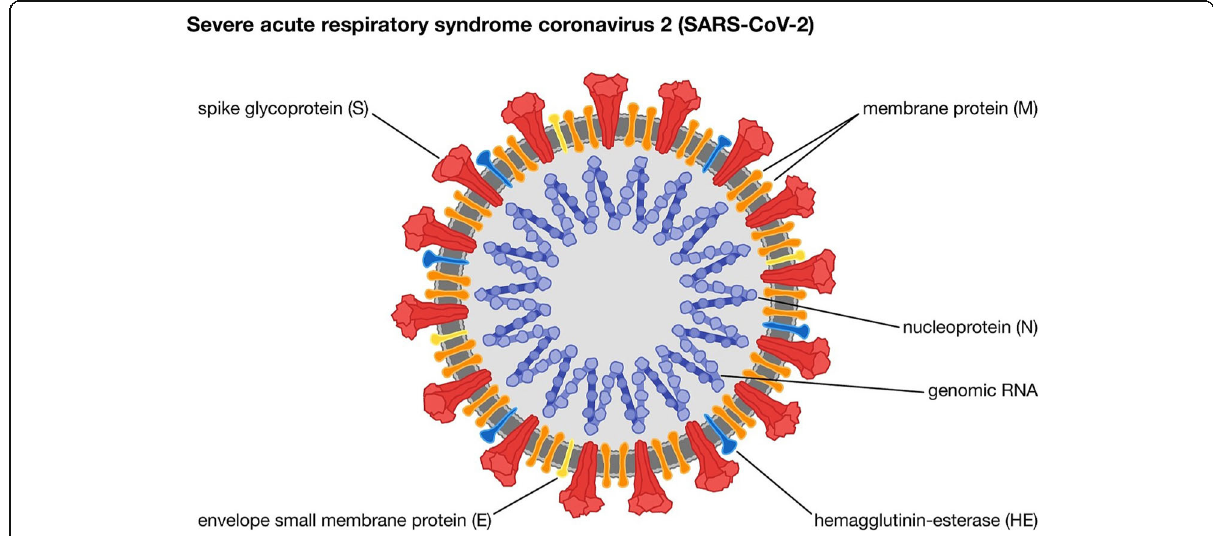
Fig. 1 Structure of novel